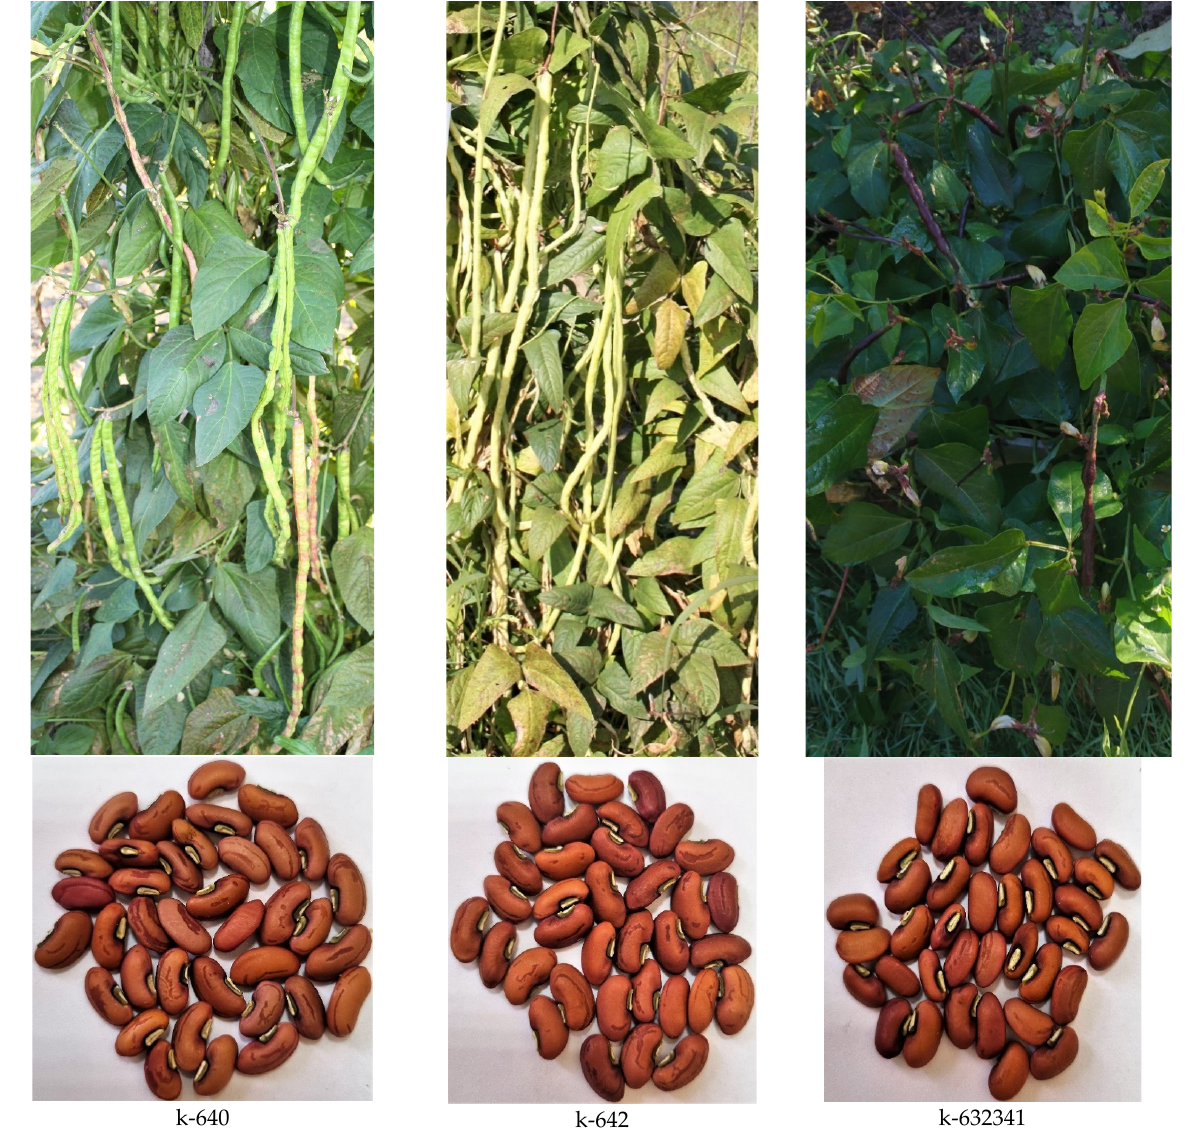
Figure 1. Samples of V. unguiculata grown at the Far East Experiment Station Branch of the Federal Research Center the N.I. Vavilov All-Russian Institute of Plant Genetic Resources. Appearance of the plants and seeds. Table 1. V. unguiculata seed material samples.